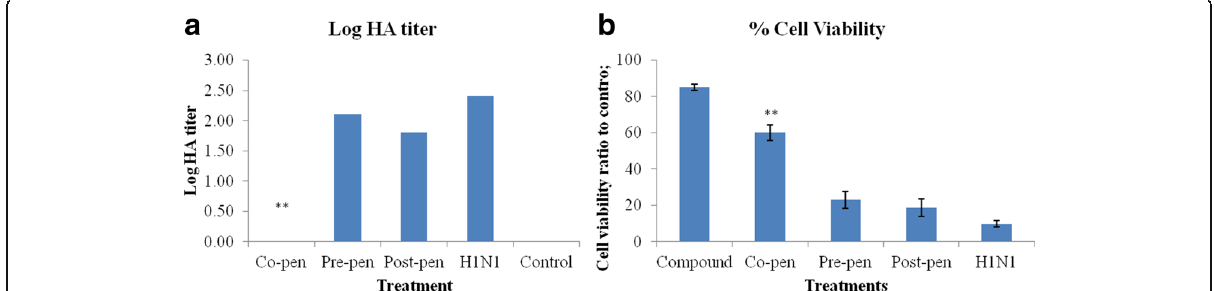
Fig. 3 The effects of the compound (150 μ g/ml) on HA titer ( a ) and cell viability ( b ) in different combination treatments. ** shows the highly